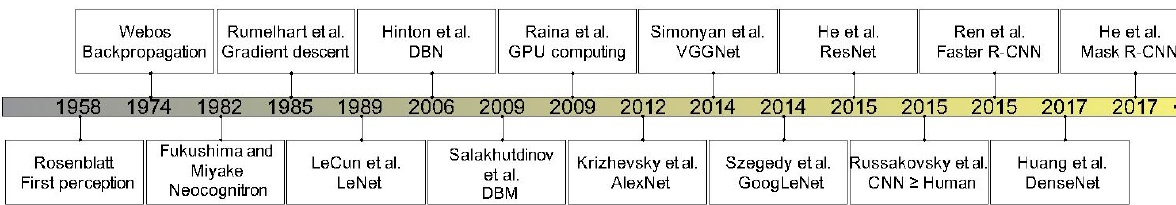
Figure 2. Some milestone events of development of artificial neural networks for convolutional neural networks in computer vision. DBN is deep brief network, GPU is graphics processing unit, DBM is Deep Boltzmann Machine, CNN is convolutional neural network, LeNet is a CNN architecture proposed by Yann LeCun, AlexNet is a CNN architecture designed by Alex Krizhevsky, VGGNet is Visual Geometry Group CNN, GoogLeNet is improved LeNet from Google, ResNet is residual network, faster R-CNN is faster region-based CNN, DenseNet is densely CNN, and mask R-CNN is mask region-based CNN. The CNN architectures after 2012 are not limited in this figure, and the selected ones are deemed influential and have at least 8000 citations in Google Scholar.